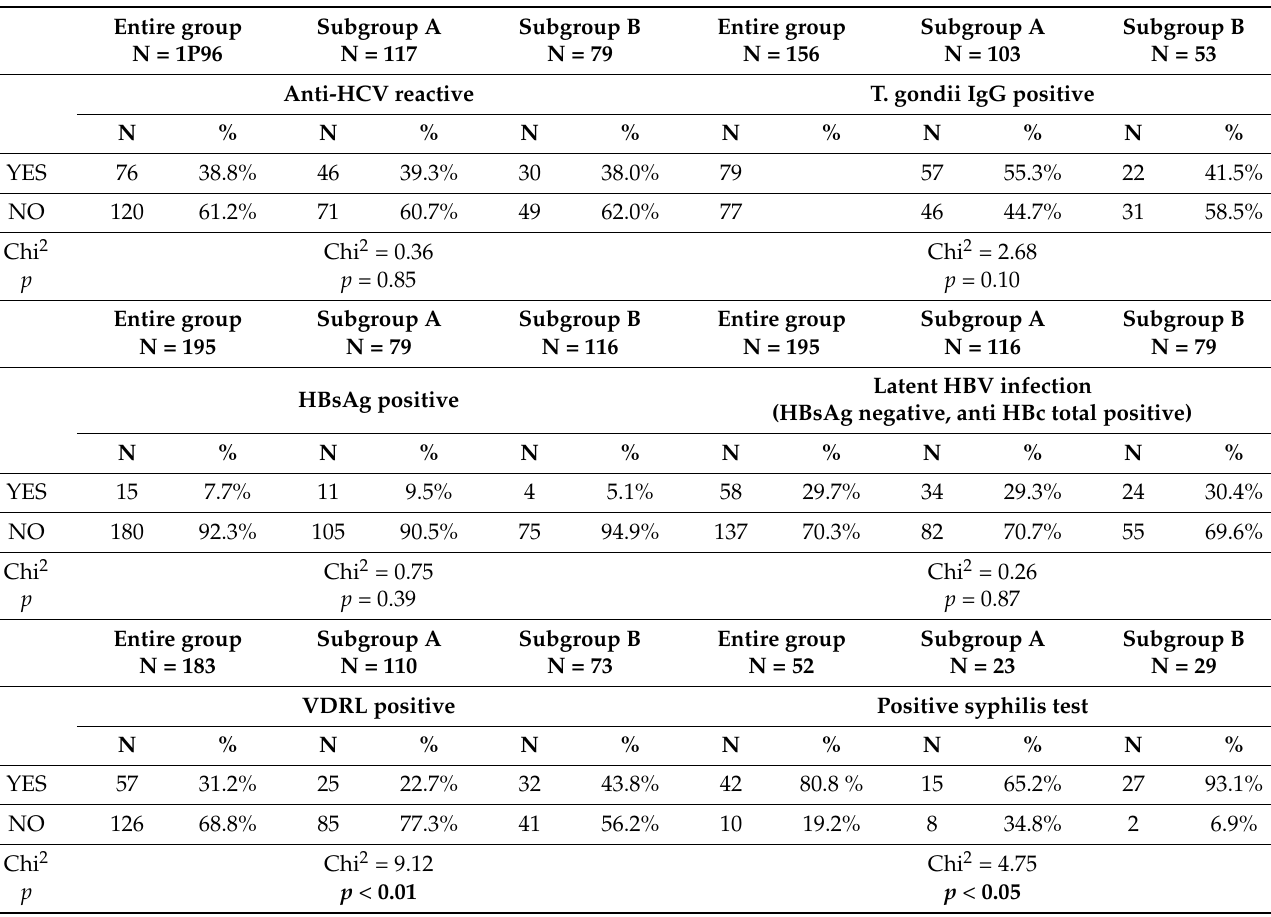
Table 5. Serological studies in the field of viral hepatitis and syphilis in particular patient